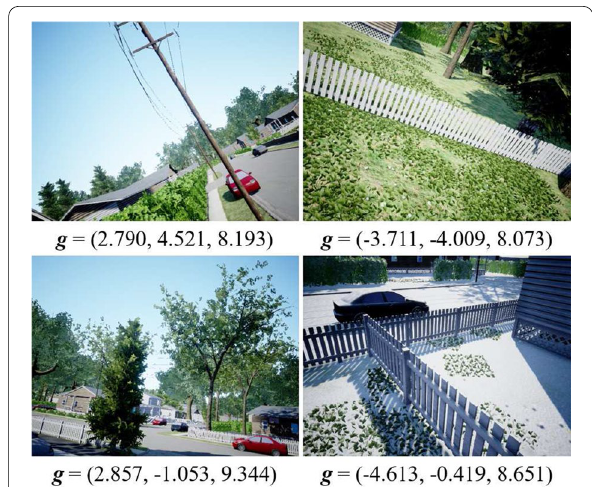
Fig. 2 Examples of datasets. The dataset consists of images and correspond gravity vectors g [ m/s 2 ] in the camera frame. These examples were collected in “Neighborhood” of AirSim. The camera pose and weather parameters are randomized for creating a dataset. An example of the weather parameter is that the road in the lower right image is covered in snow